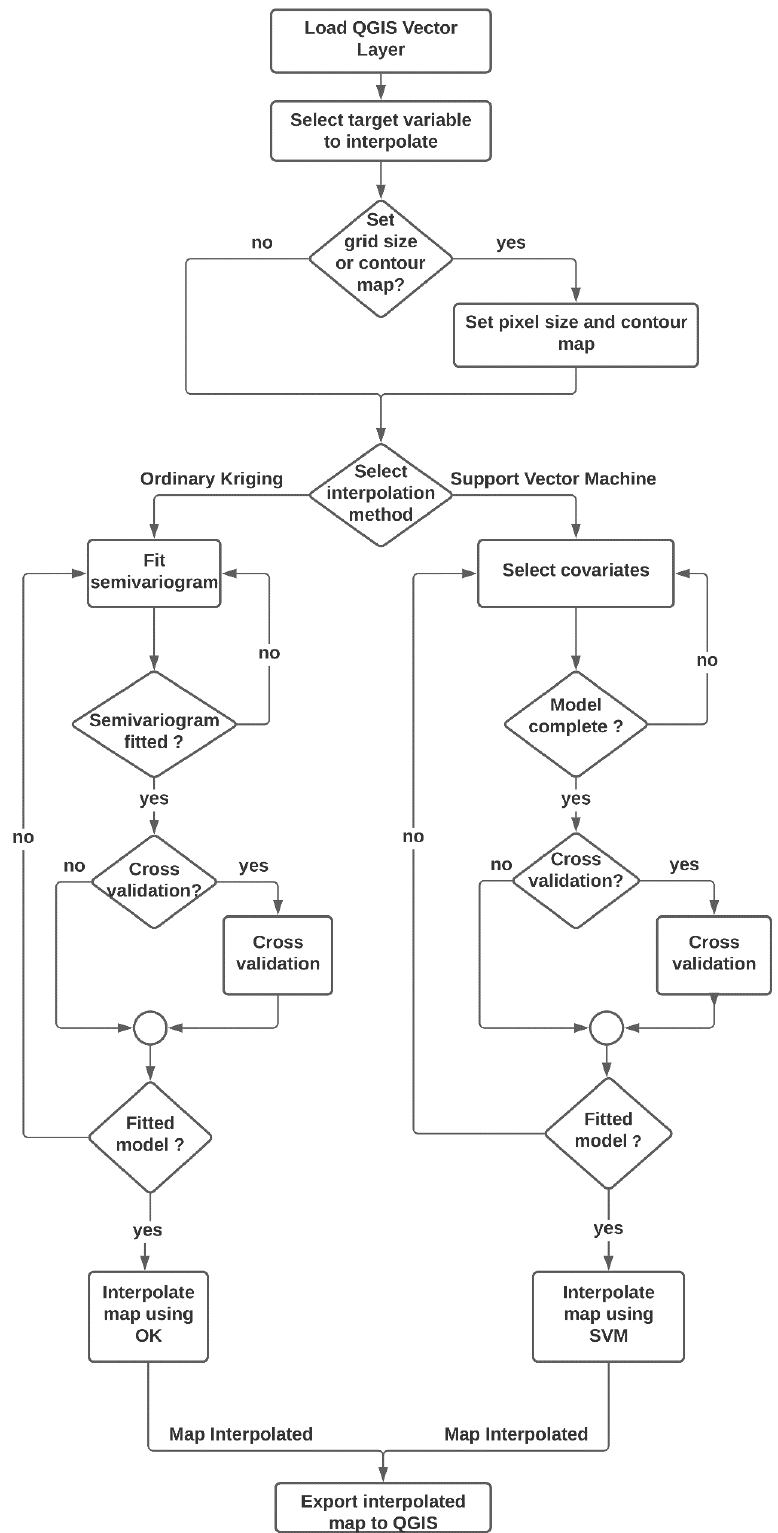
Figure 1. Flowchart of the main processing steps of Smart-Map.